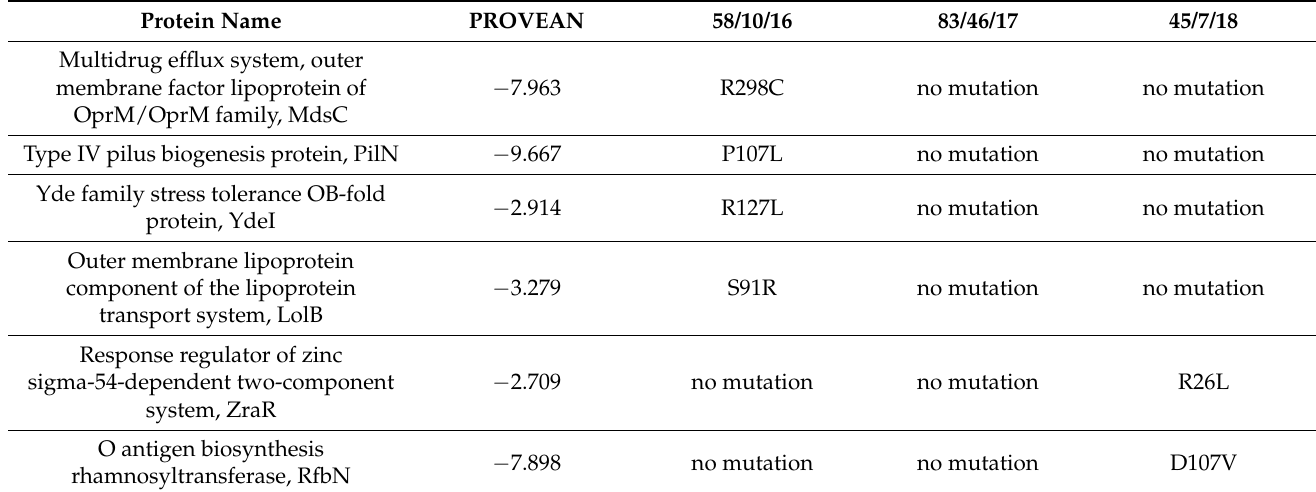
Table 2. WGS characterisation of deleterious mutated proteins potentially related with COL resistance in COL-R mcr negative S . Enteritidis